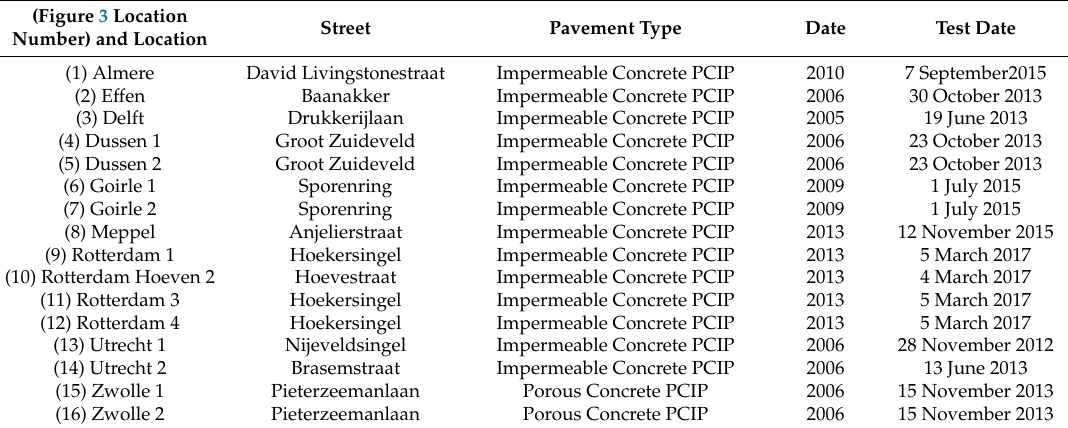
Table 1. 16 Dutch permeable pavements tested in the study. (Figure 3 Location Number) and